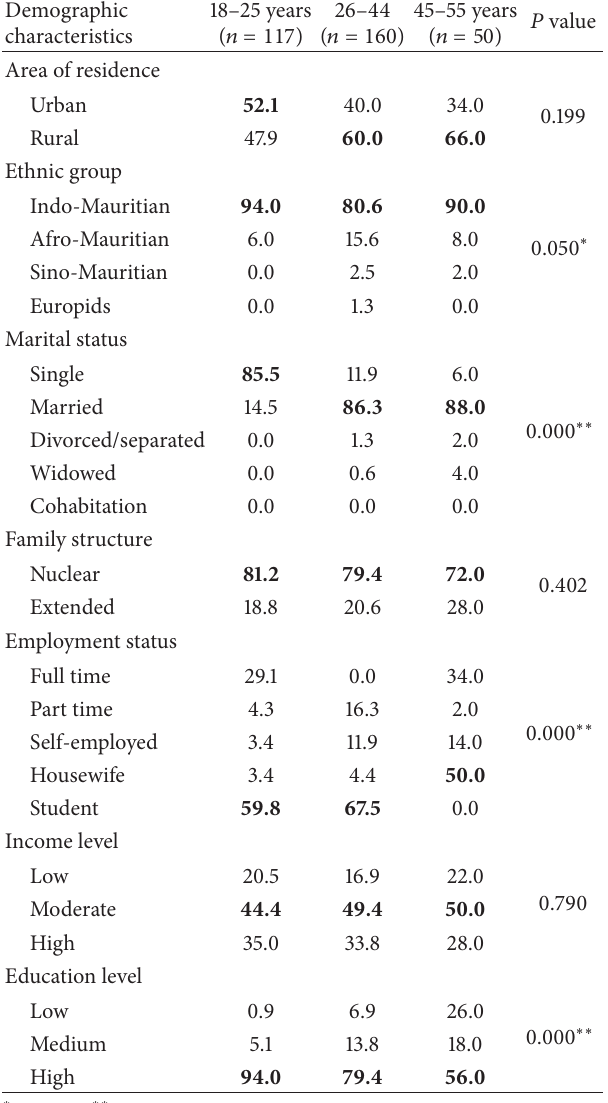
Table 2: Percentage distribution of sample sociodemographic char- acteristics. women with low income level, educational level, PAL, and